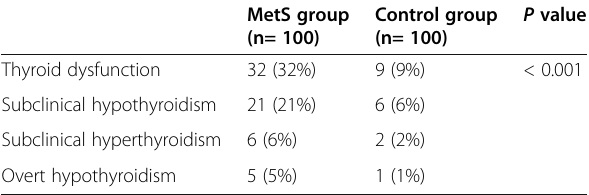
Table 6 Correlation of thyroid hormones with metabolic syndrome